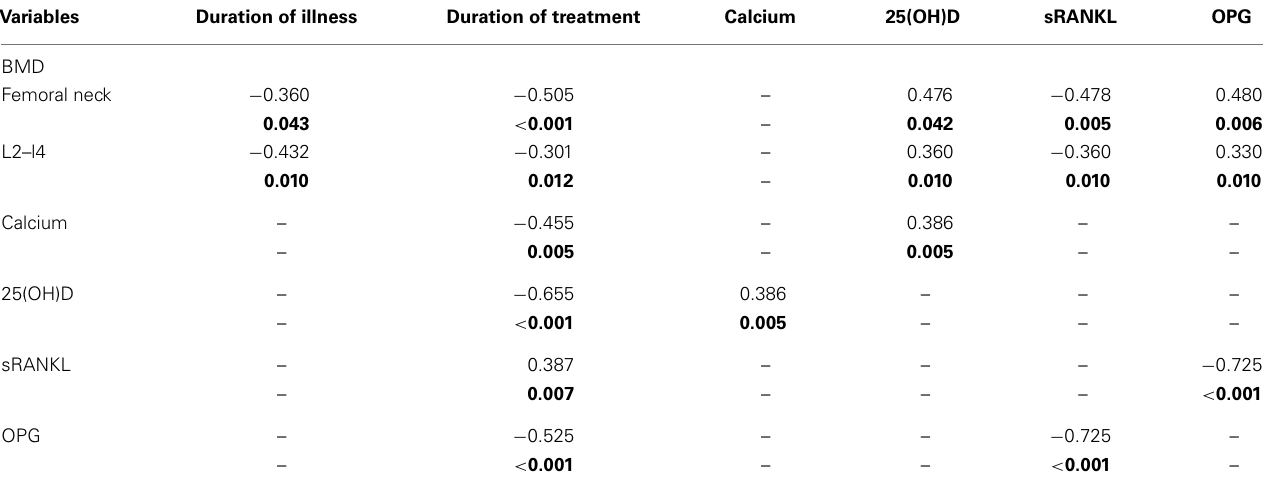
Table 6 | Correlations between demographic-, clinical-, laboratory- and DEXA parameters